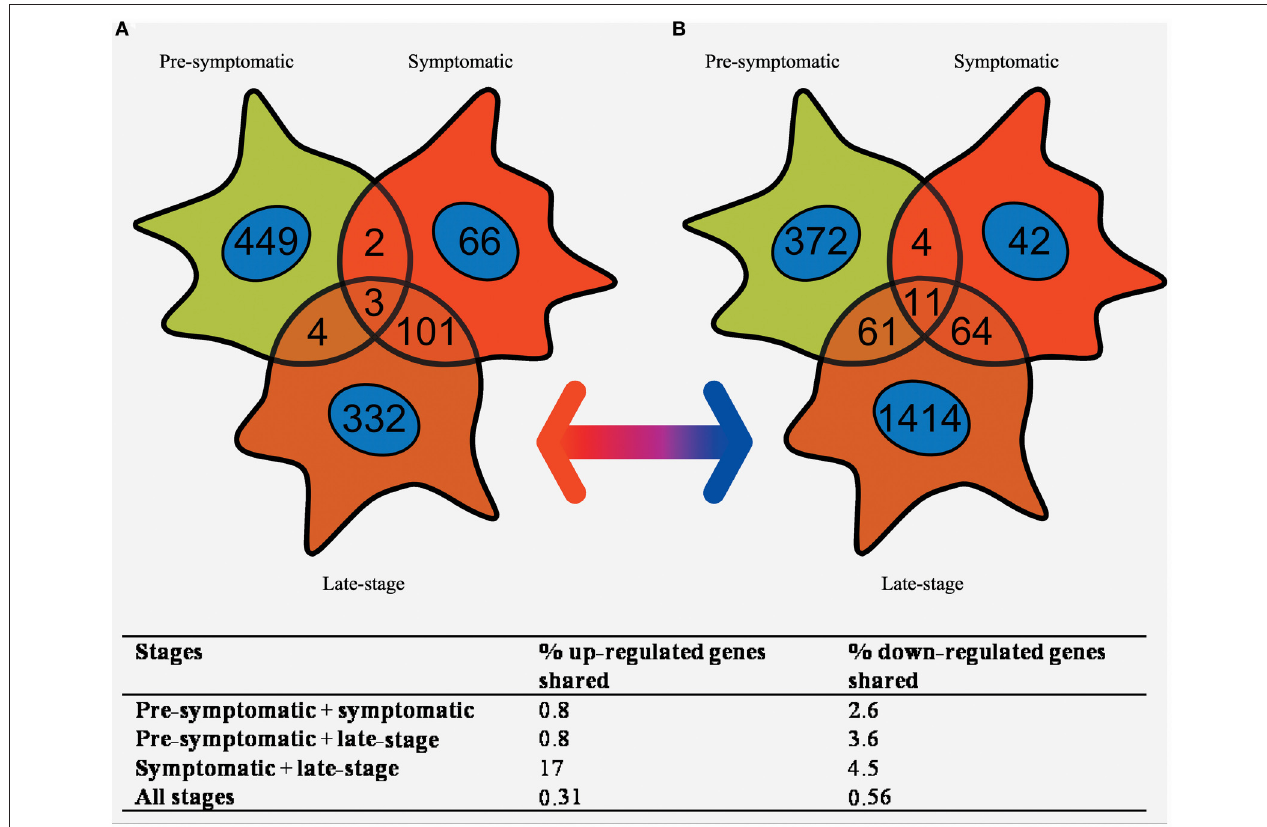
FIGURE 4 | Venn diagram of the (A) up-regulated and (B) down-regulated genes that are differentially expressed in SOD1 G93A astrocytes at pre-symptomatic, symptomatic, and late-stage disease. The greatest overlap occurs between up-regulated transcripts in symptomatic and late-stage SOD1 G93A astrocytes. In comparison very few genes are shared between pre-symptomatic astrocytes and the other two disease stages, or between all three disease stages